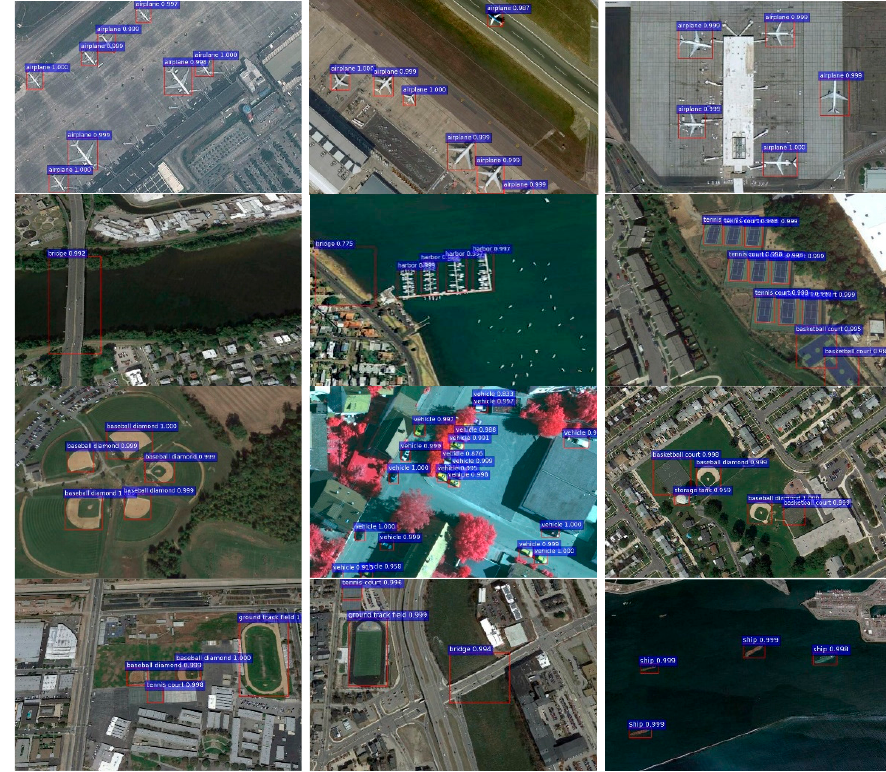
Figure 12. Some detection results of the Multi-stage FEPN with NWPU VHR-10.